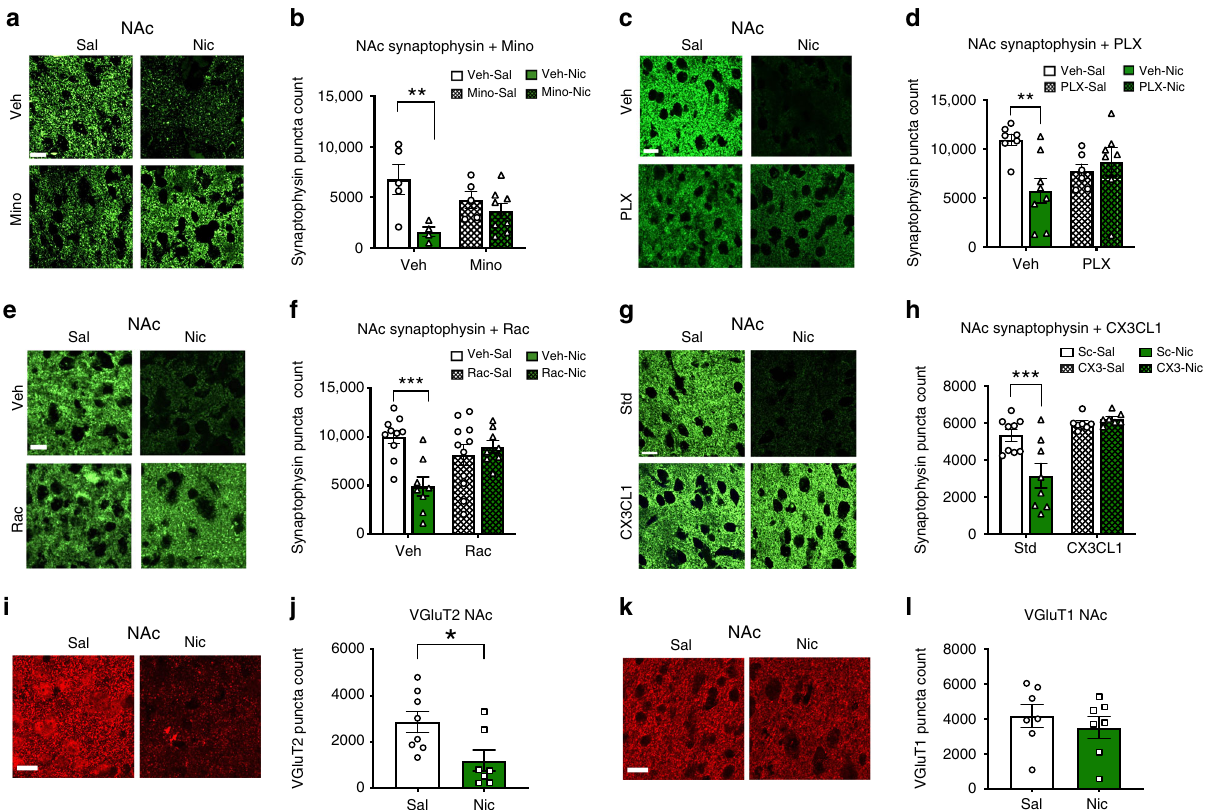
Fig. 7 Nicotine induces a decrease in synaptic density that is microglia, D2 and CX3CL1 dependent. a Representative images of synaptophysin levels in the NAc following saline/nicotine and vehicle/minocycline exposure. b Minocycline administration prevented nicotine-induced suppression of NAc synaptophysin count ( F (1,18) = 9.692), p = 0.0055, η 2 = 32.59) ( n = 5 vehicle-saline, 4 vehicle-nicotine, 5 minocycline saline, 8 minocycline nicotine). c Representative images of synaptophysin levels in the NAc with nicotine/saline and/or PLX3397/vehicle chow administration. d PLX3397 blocks nicotine induced decreases in NAc synaptophysin levels ( F (1,24) = 7.412, p = 0.0119; η 2 = 20.77, n = 7 vehicle-saline, 8 vehicle-nicotine, 6 PLX3397-saline, 7 PLX3397-nicotine). e Representative images of synaptophysin in the NAc with nicotine and/or raclopride administration. f Nicotine-induced decreases NAc synaptophysin counts ( F (1,33) = 5.58, p = 0.0242; η 2 = 11.18%) were blocked with raclopride ( F (1,33) = 10.88, p = 0.0023; η 2 = 21.81%) ( n = 10 vehicle-saline, 8 vehicle-nicotine, 11 raclopride-saline, 8 raclopride nicotine). g Representative images of synaptophysin levels in the NAc following saline/ nicotine and scrambled /CX3CL1 targeted oligo treatment. h Nicotine suppressed NAc synaptophysin levels ( F (1, 27) = 5.889, p = 0.0222, η 2 = 9.284), and this was blocked with CX3CL1 RNAi ( F (1, 27) = 21.21, p = < 0.0001, η 2 = 33.45). A signi fi cant interaction between nicotine and CX3CL1 RNAi was observed ( F (1, 27) = 9.198, p = 0.0053, η 2 = 14.50). i Representative images of Vglut2 staining in the NAc. j Nicotine suppresses Vglut2 levels in the NAc Vglut1 levels ( n = 7). Data analyzed with a two-way ANOVA was further analyzed with Bonferroni post hoc tests (* p < 0.05, ** p < 0.01, *** p <